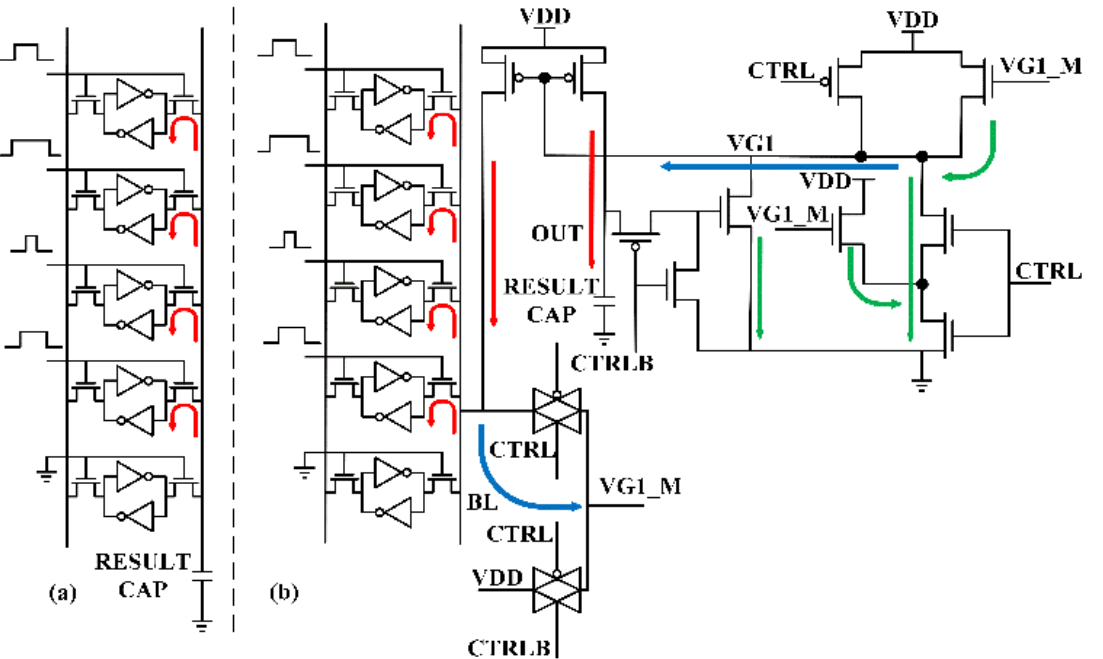
Figure 2. Plots of: ( a ) Multi-row read operation in conventional CIM designs. ( b ) Multi-row read operation in a CIM design with our proposed compensation circuit.